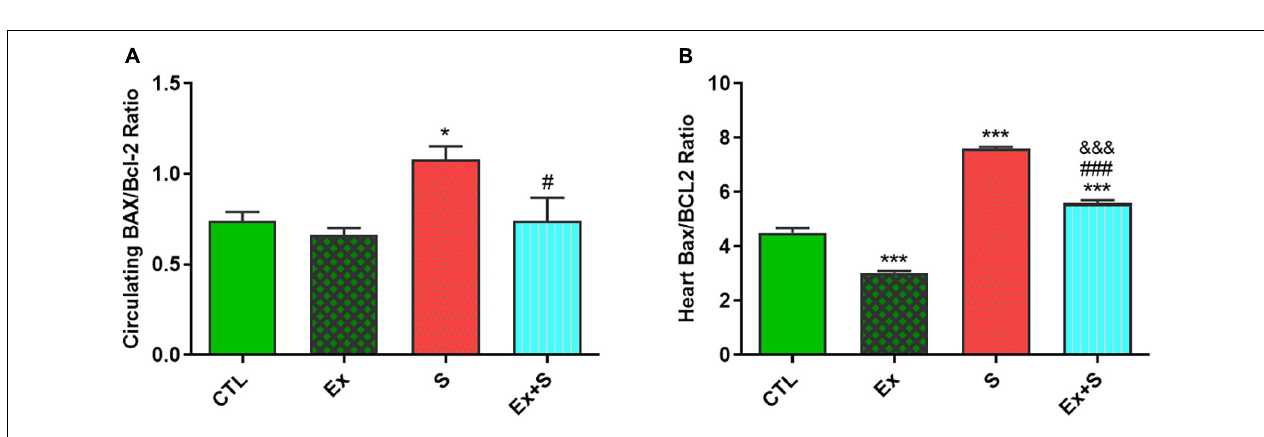
( P < 0.05 vs. CTL) ( Table 1 ). Smoke inhalation induced mild